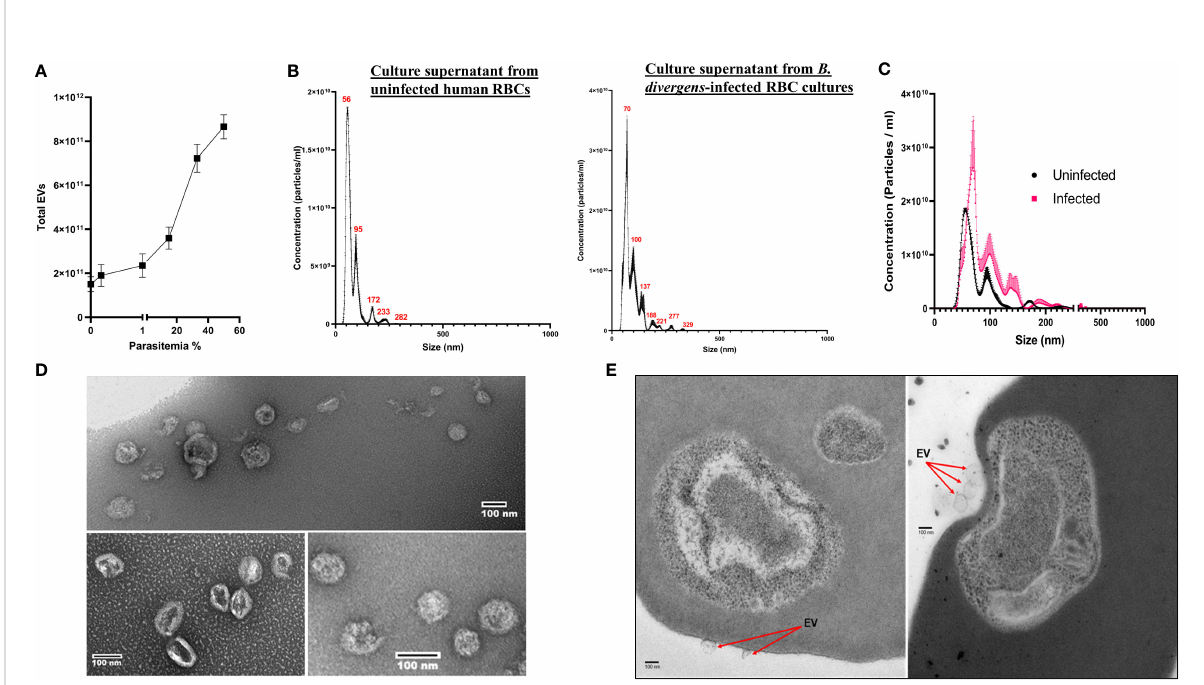
FIGURE 1 Characterization of extracellular vesicle (EV) derived from B. divergens – infected red blood cells (RBCs). EVs present in spent culture media of uninfected RBCs (uRBCs) and B. divergens – infected RBCs (iRBCs) were used for the analysis. (A) Total EVs in B. divergens spent culture supernatant increase with an increase in parasitemia. Approximately, a 4-fold increase in EV numbers was obtained as parasitemia increased from 10% to 60%. (B) Nanoparticle tracking analysis was performed on supernatant from uRBCs and B. divergens iRBCs. Pro fi le of size (in nm) concentration is shown. As evident, the highest concentration peak of EVs in uRBCs was ~55 nm, whereas for iRBCs, it was ~70 nm. iRBCs also demonstrated a wider distribution of size of EVs as compared with uRBCs. (C) Direct comparison between uRBCs and iRBCs (~10% parasitemia) with respect to size (in nm) of EVs. At this parasitemia, iRBCs had 1.8- to 2-fold higher number of EVs as demonstrated by “ concentration (particles/ml) ” in the y-axis. (D) Density gradient – dependent puri fi cation of EVs was performed, followed by negative staining and visualization under transmission electron microscopy. A range of different sizes of EVs from B. divergens – derived culture supernatant were seen, concurrent with nanoparticle tracking analysis shown in (B) . (E) When RBCs were visualized, particles in the size range of EVs were seen on the surface of red cells shown in (C)